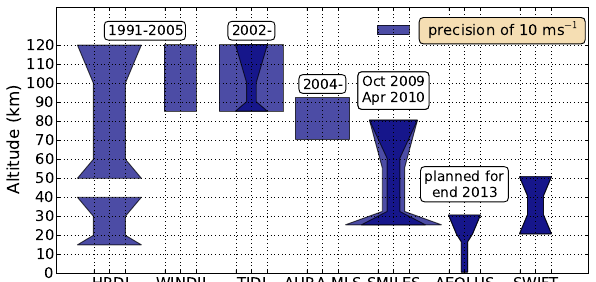
Fig. 1. The height coverage and estimated precision of past, current and future wind measuring instruments: reported validated preci- sions are in blue and theoretical values are in darker blue. HRDI (Ortland et al., 1996) and WINDII (Shepherd et al., 1993) were on the UARS satellite and operated from September 1991–June 2005, TIDI (Niciejewski et al., 2006) operates on the TIMED satel- lite from 2002-present, AURA-MLS (Wu et al., 2008) operates on the AURA satellite from July 2004–present (note that wind is not a standard product), SMILES operated on the ISS from September 2009–April 2010, Aeolus is ESA mission (Stoffelen et al., 2005) planned for 2013 and SWIFT (McDade et al., 2001) is under study in